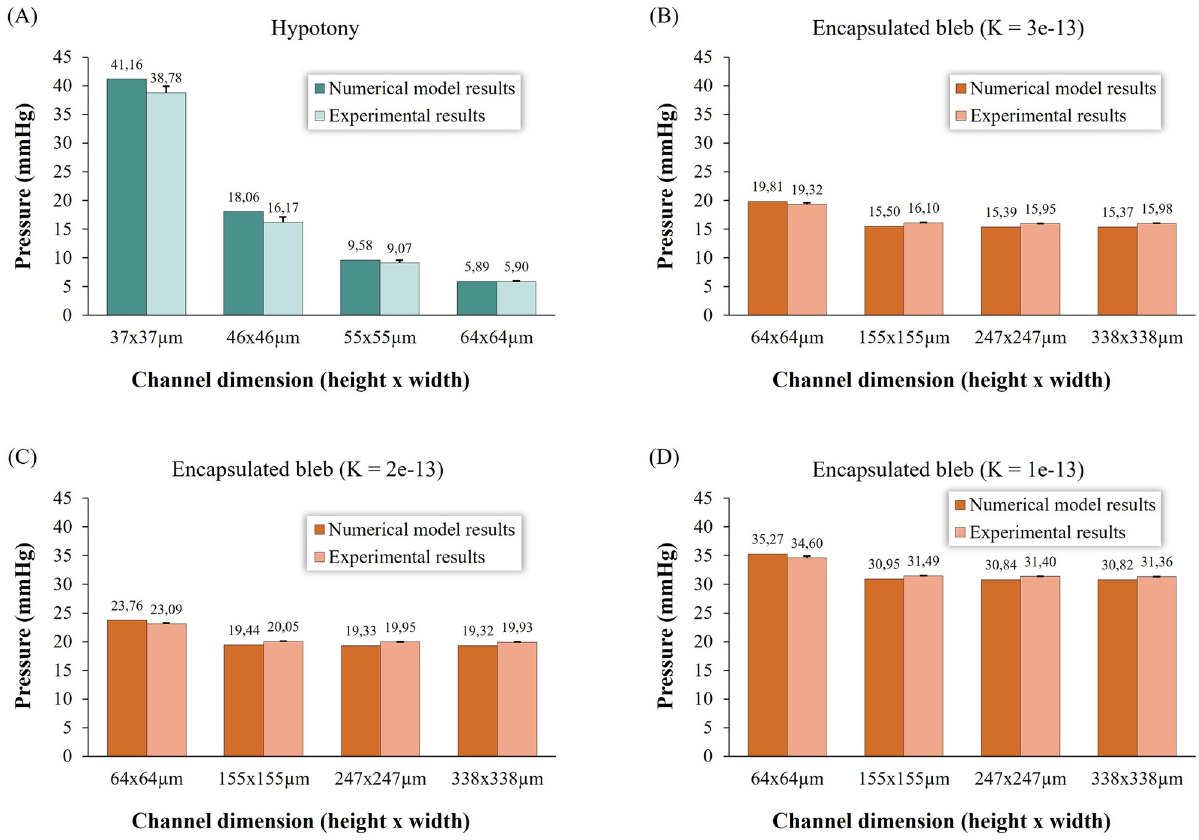
Fig 11. Calculated IOP vs. experimental IOP. Comparison between the IOPs calculated with the model and the IOPs measured in the microfluidic experiments in case of (A) hypotony and (B) , (C) and (D) bleb encapsulation, and for different shunt lumen diameters/channel dimensions.